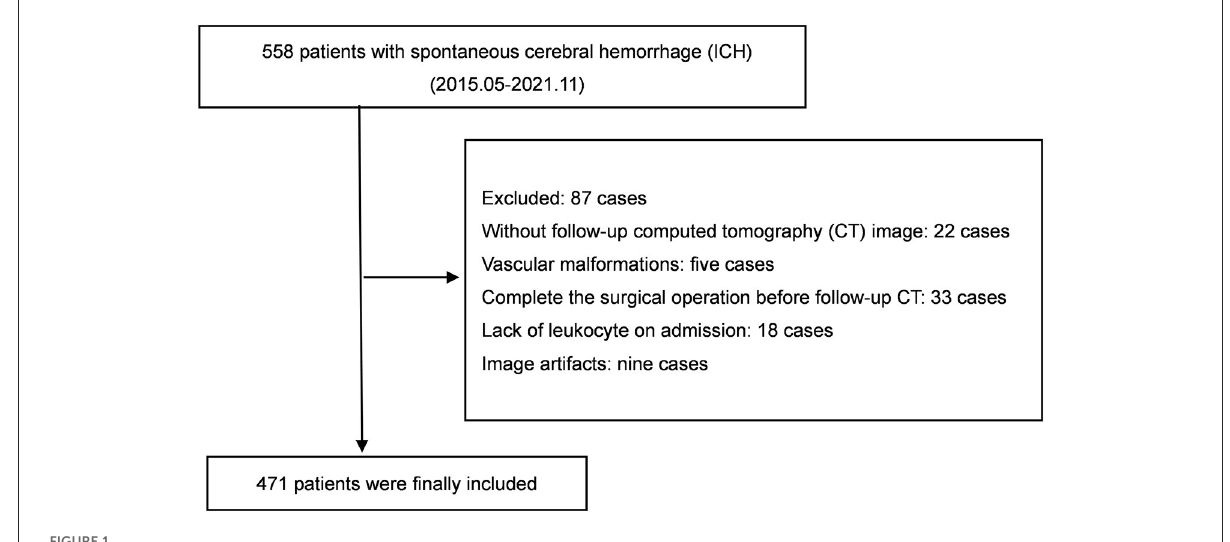
FIGURE1 Flowchart of cohort